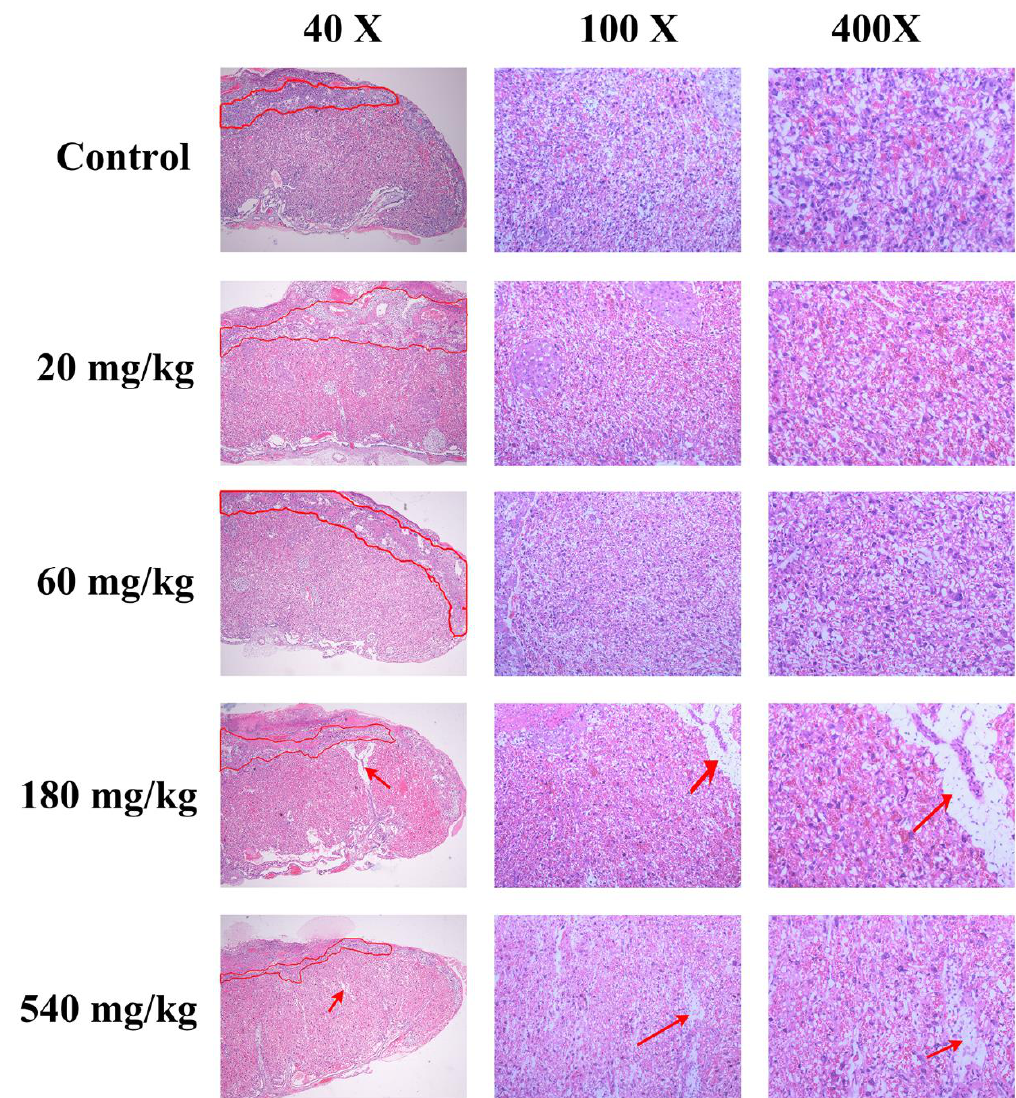
Figure 3. Histological images of the placenta from pregnant mice. The area circled by red circles means spongiotrophoblast, red arrows mean placental structure damage.